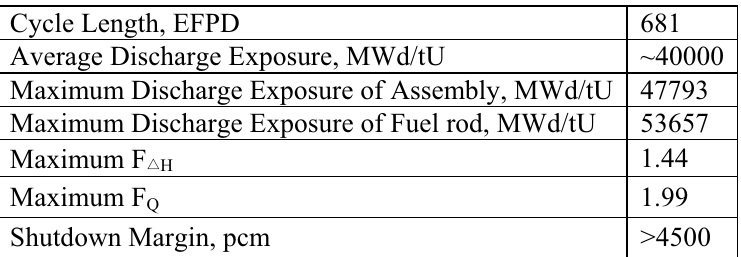
Table VI : Main Results of Boron and CRs Co-Controlled Core